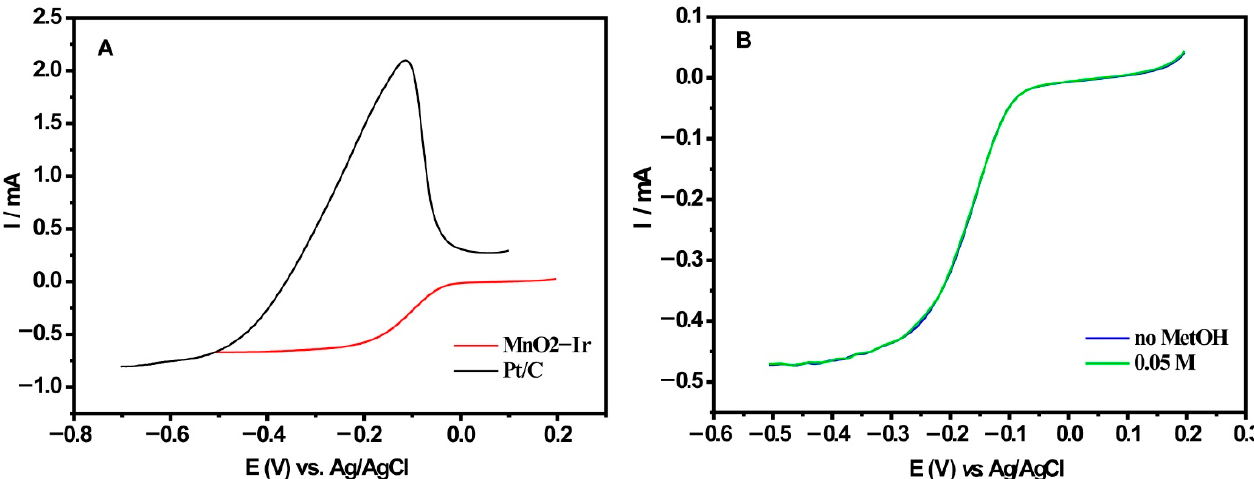
Figure 7. ( A ) Comparison between the ORR polarization curves of MnO 2 -Ir and Pt/C electrocatalysts and ( B ) ORR polarization curves recorded for the MnO 2 -Ir electrocatalyst without methanol and at 0.05 M of the alcohol.